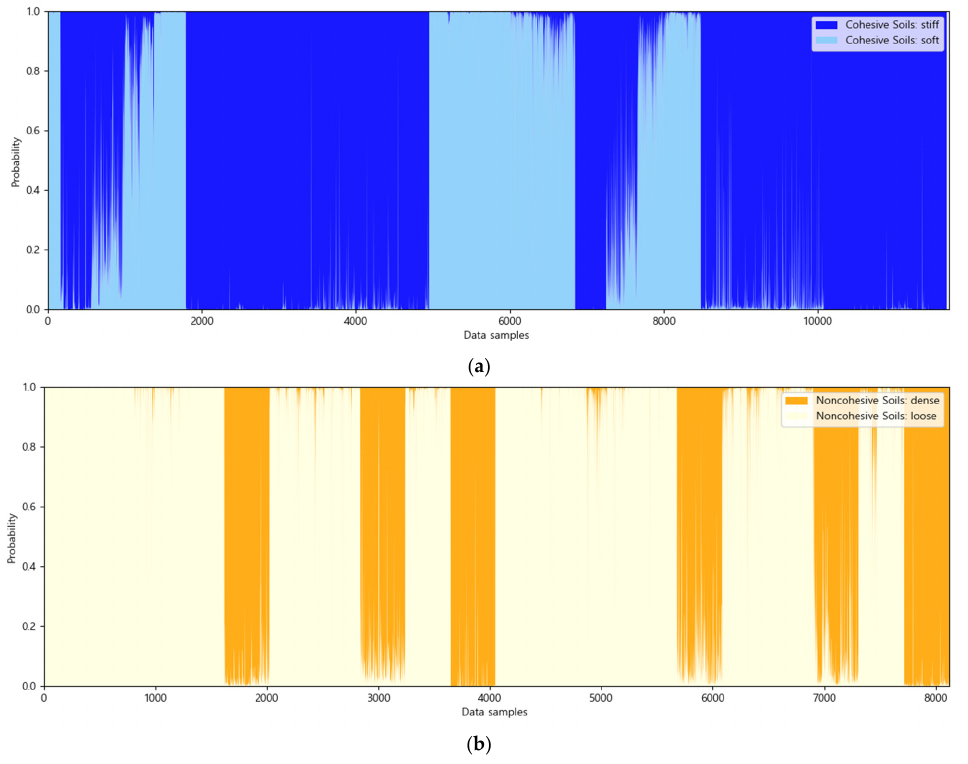
Figure 9. Prediction results by classification models (step 2: N-value): ( a ) cohesive soils; ( b ) non-cohesive soils.